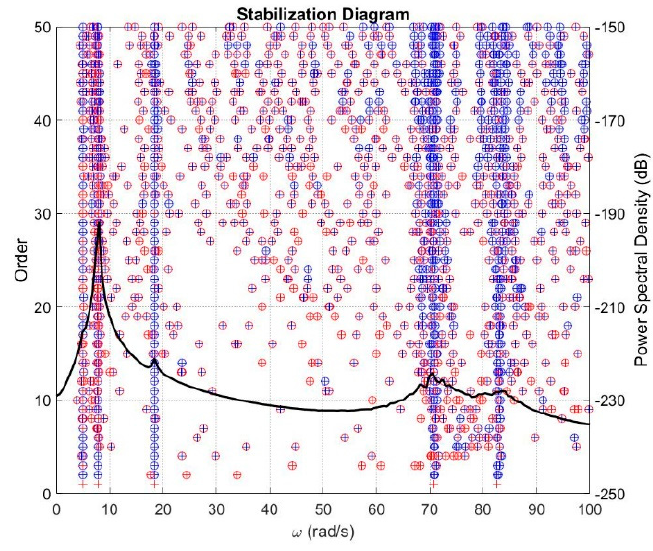
Figure 12. Stabilization diagram of seven-DOF car model. Table 4. Modal parameter identification result of seven-DOF car